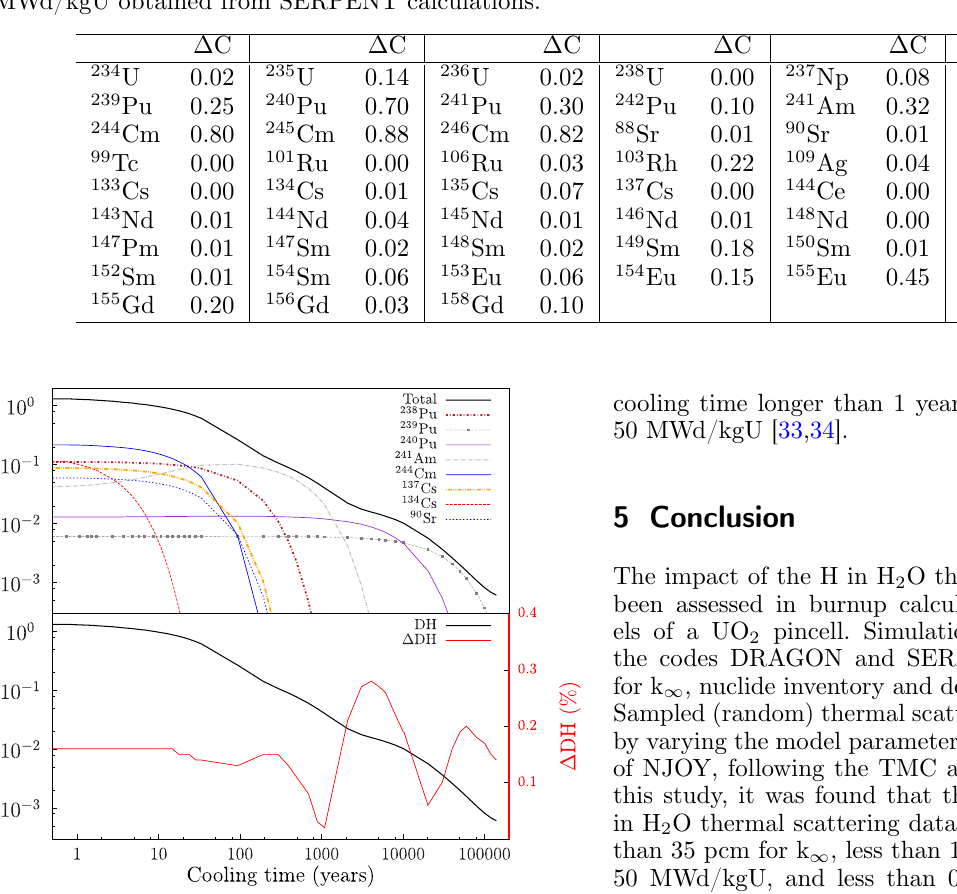
Fig. 6. Decay heat, contributors and its uncertainty due the variations of the thermal scattering data, for the UO 2 pincell obtained with